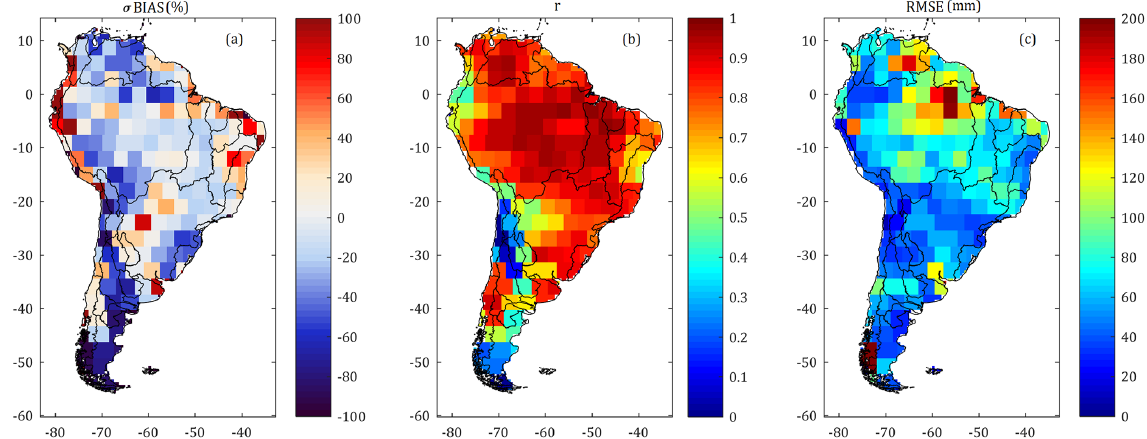
Figure 8. Comparison between MGB and GRACE (JPL RL05 v2 mascon solution) TWS anomalies in terms of (a) bias in standard deviation, (b) correlation and (c)